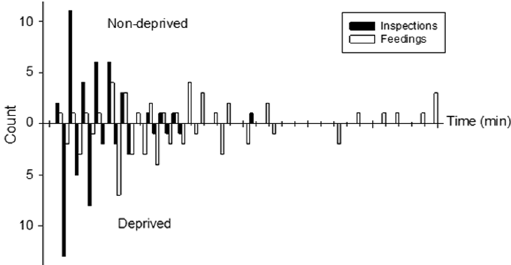
Figure 1. Paired histogram of the distribution in time to first inspection (black bars) and the time to first feeding (white bars) with the non-deprived larvae occupying the positive Y-axis and the deprived larvae the negative Y-axis are shown in this figure. Both time to first inspection and time to first feeding were significantly (p < 0.05) shorter for the deprived larvae compared to the non-deprived larvae. The distribution time and time to first feeding were observed in 6 larvae from each deprived and non-deprived group for a total 30 minutes per larva (N =